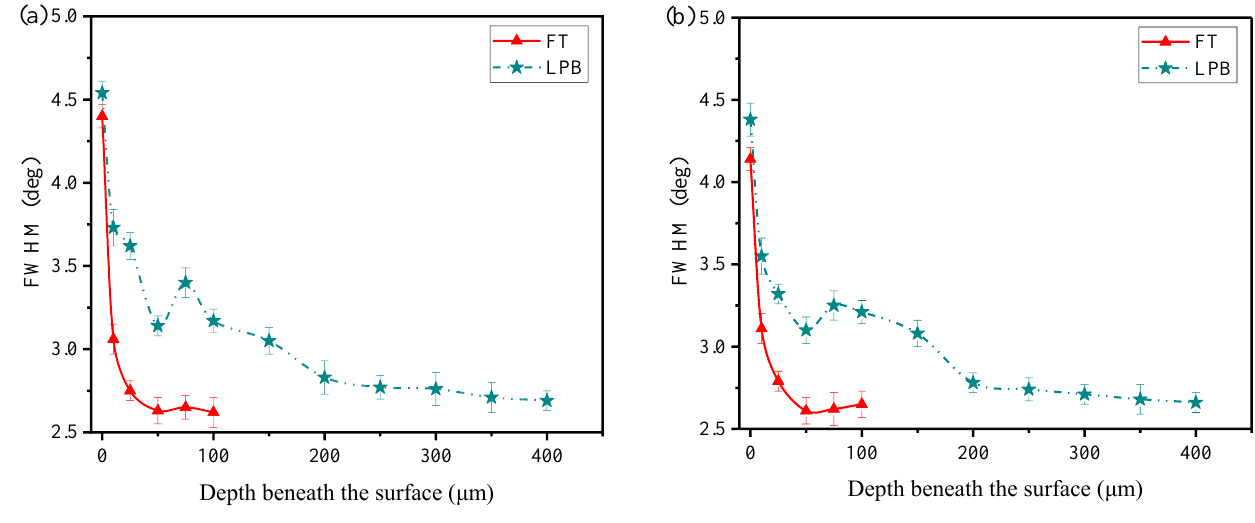
Figure 13. FWHM distribution in depth beneath the surface in the ( a ) longitudinal direction and ( b ) transverse direction.